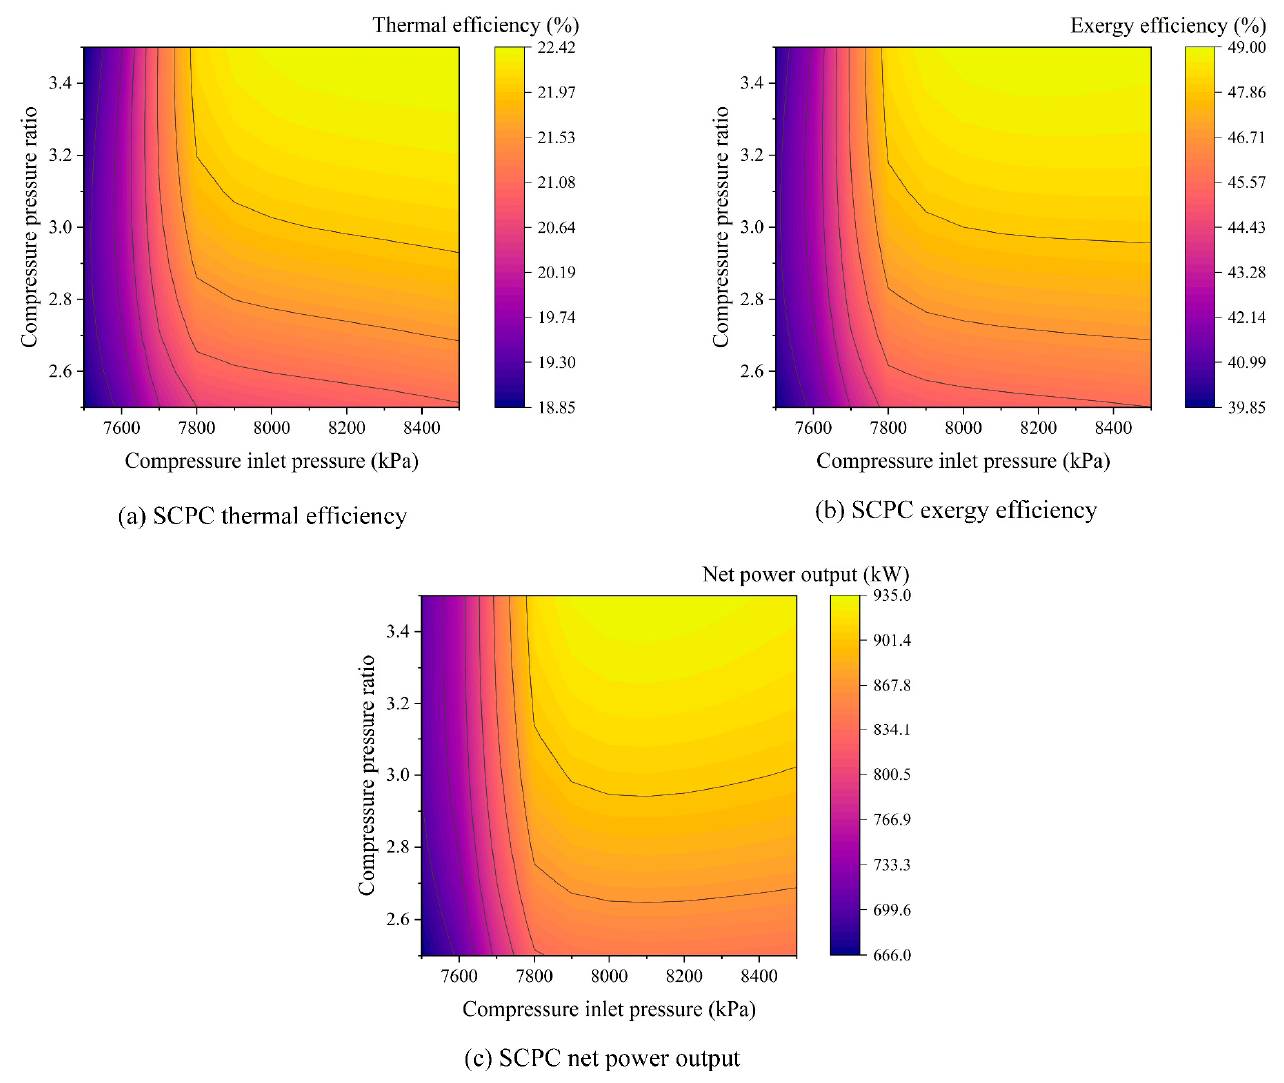
Figure 7. The influences of compressor inlet pressure and pressure ratio on the performance of the SCPC: ( a ) thermal efficiency; ( b ) exergy efficiency; ( c ) net power output. SCPC: ( a ) thermal efficiency; ( b ) exergy efficiency; ( c ) net power